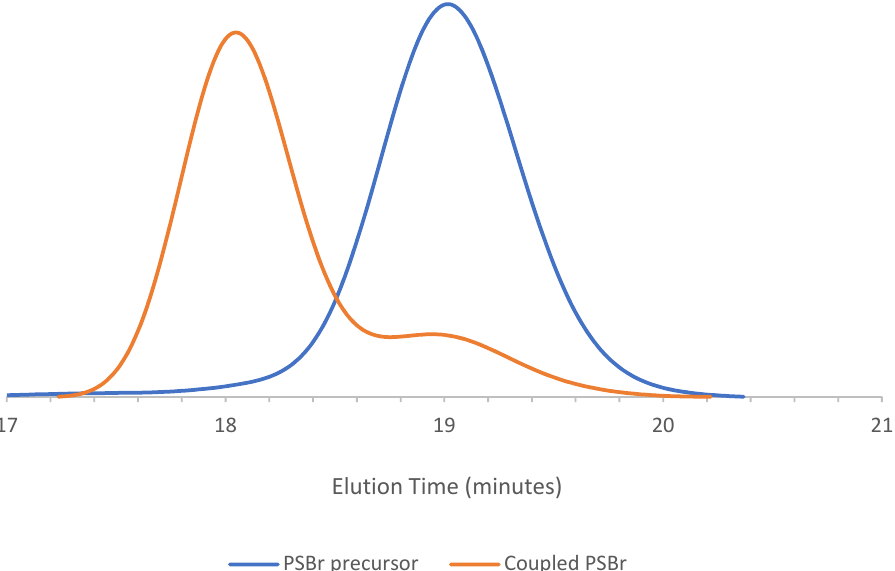
Figure 4. GPC traces of PSBr precursor (blue) and RTA-ATRC product (orange) under universal conditions using MNP as the radical trap-assist. Traces correspond to Table 3, Trial 25.